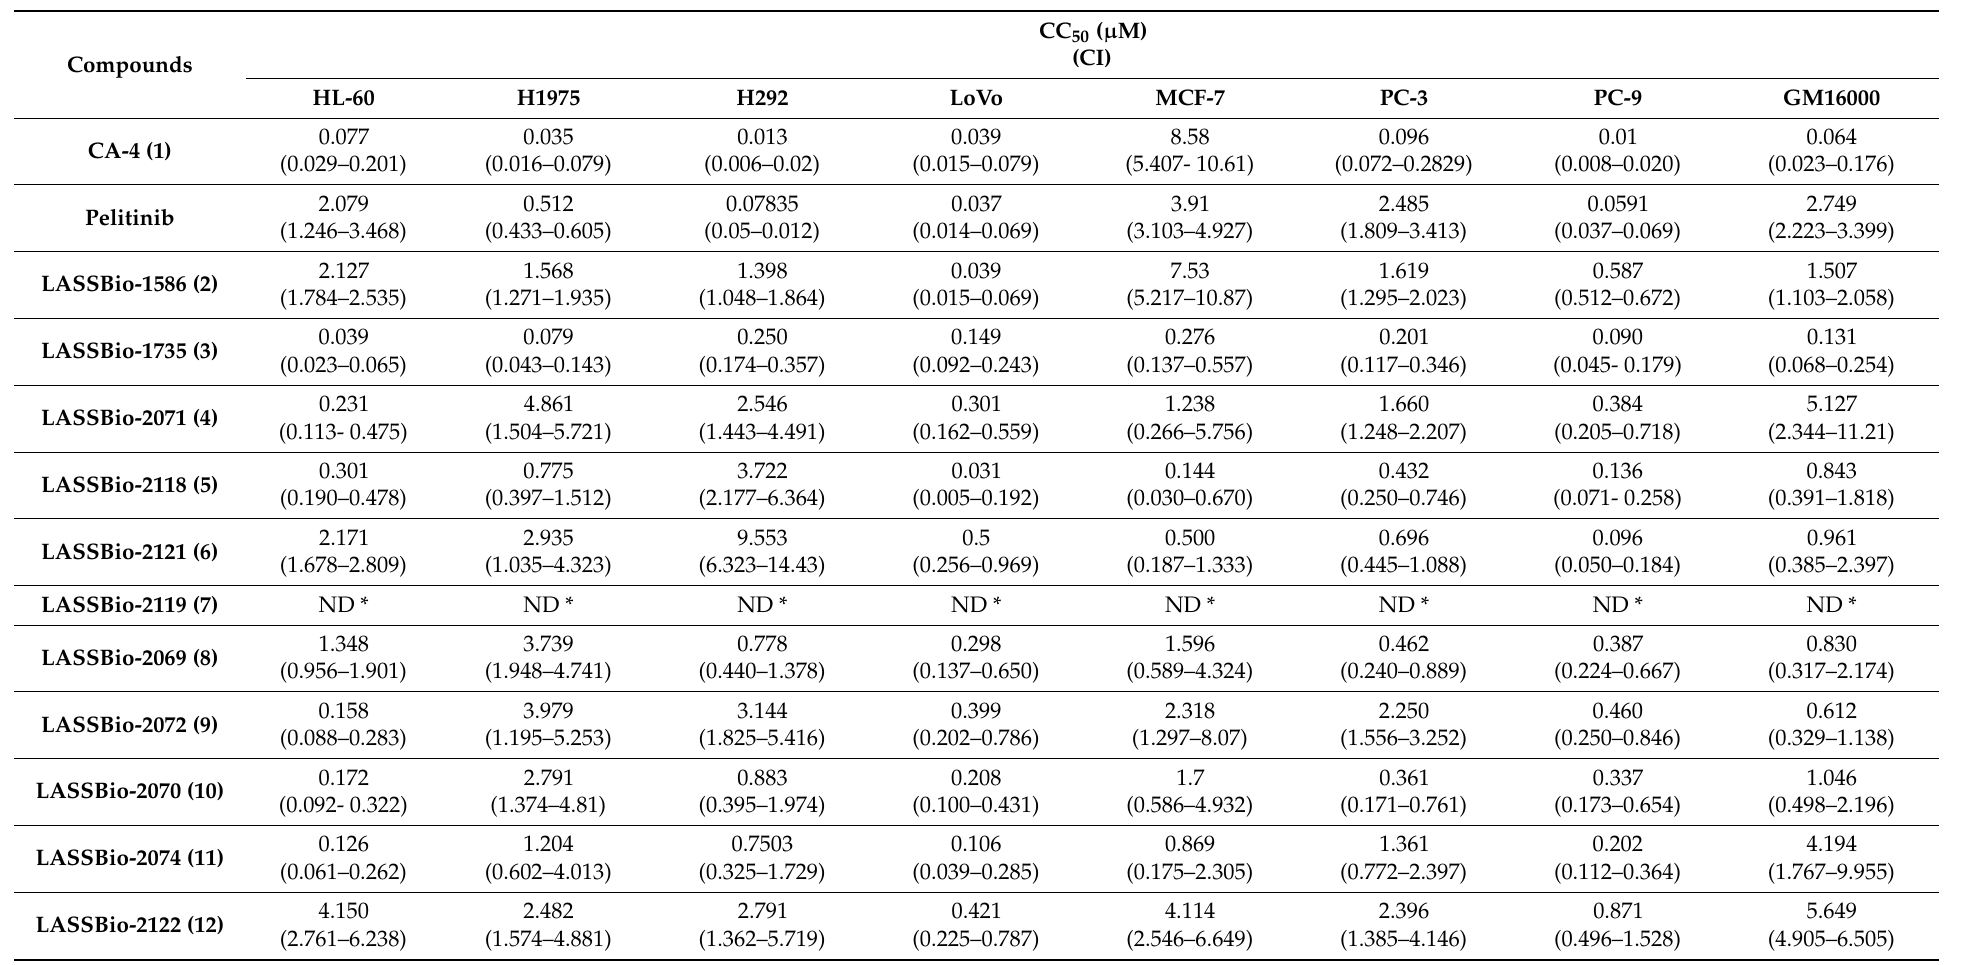
Table 2. Cytotoxic potency activity (mean CC 50 ± CI) of compounds 2 – 12 , and the standards CA-4 and pelitinib, against tumor cell lines and GM16000 at 72